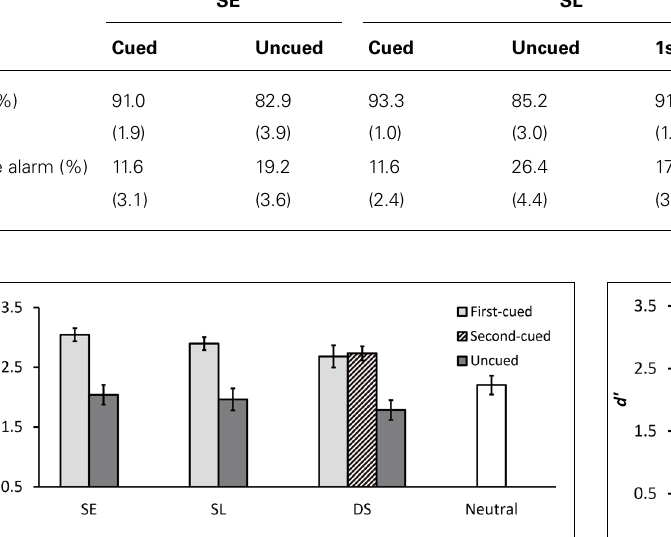
trials than on uncued and neutral trials. This is inconsistent